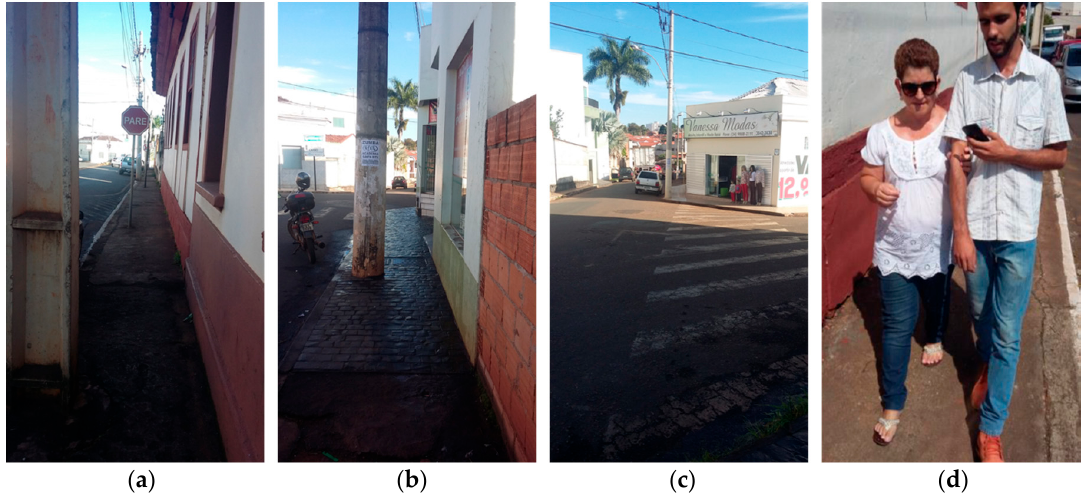
Figure 5. ( a–c ) Scenario of the experiment; ( d ) navigation task with a volunteer.